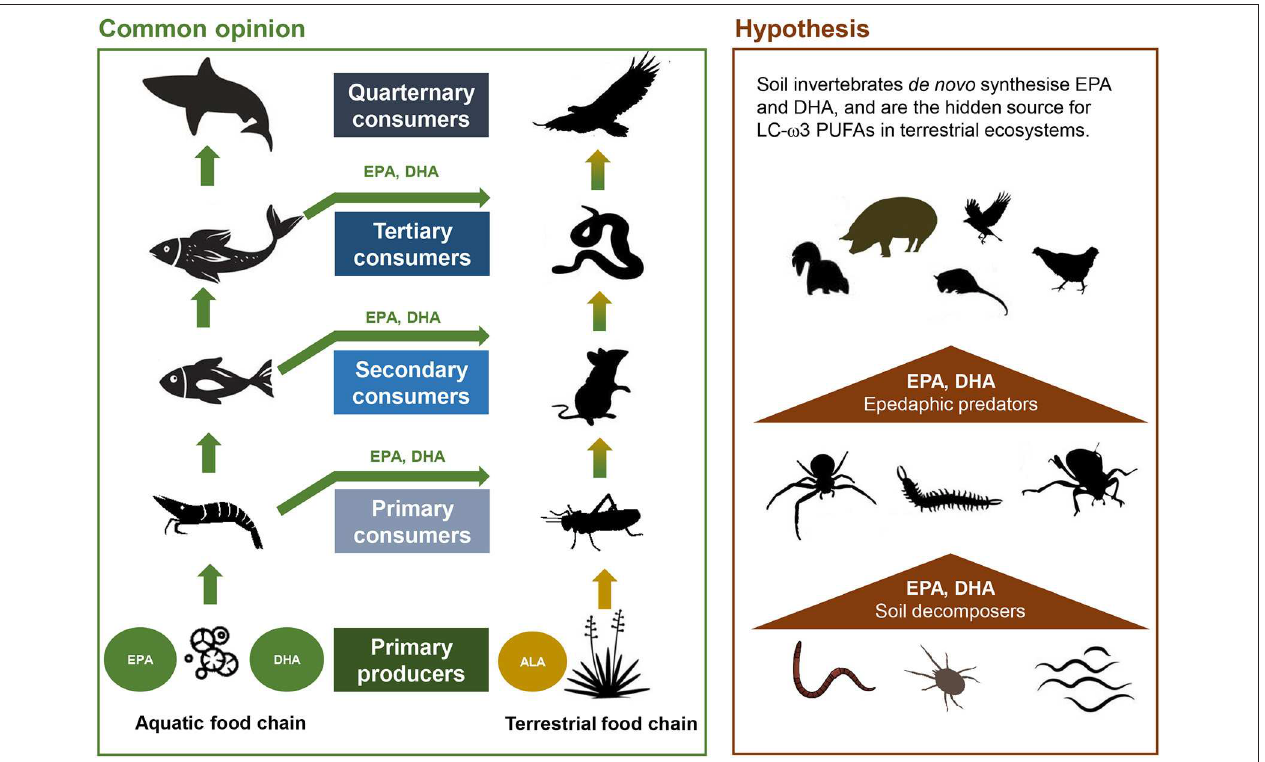
FIGURE 3 | Proposed origin of long-chain polyunsaturated fatty acids (LC-PUFA) in terrestrial ecosystems. Left—transfer to land via different trophic levels of the aquatic food chain is commonly regarded as major input; right—soil decomposers are a neglected source. Please note that “hidden” channels such as mutualistic gut microbiota in e.g., earthworms or ruminants, are not specifically emphasized. ALA, α -linolenic acid; EPA, eicosapentaenoic acid; DHA, docosahexaenoic acid. Illustration credit: